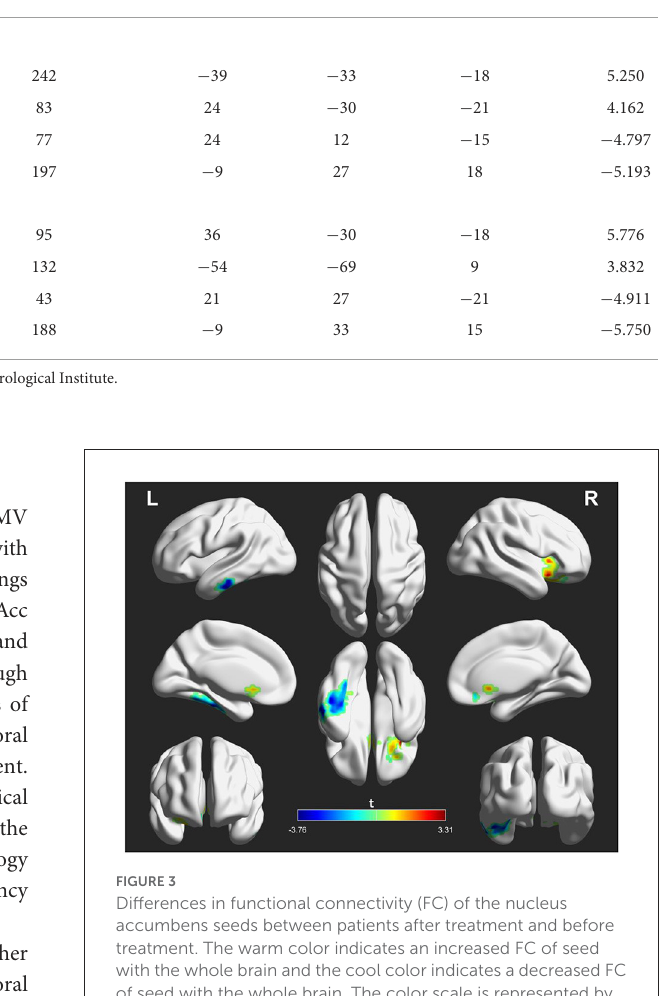
anterior cingulate gyrus was also observed in patients at